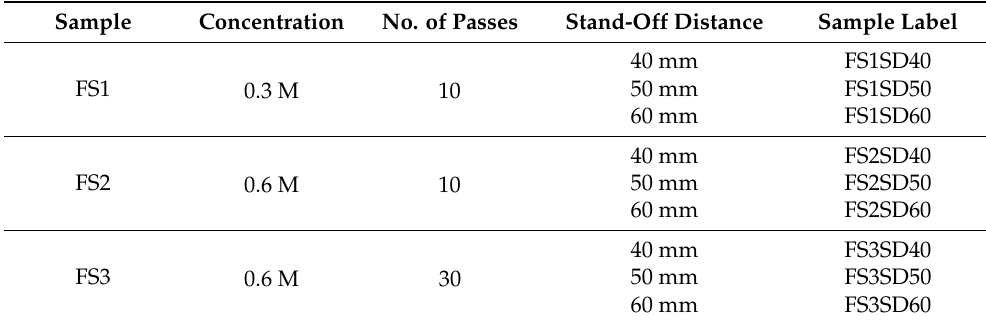
Table 1. Sample determination according to varying solution concentrations and stand-off dis- tances.